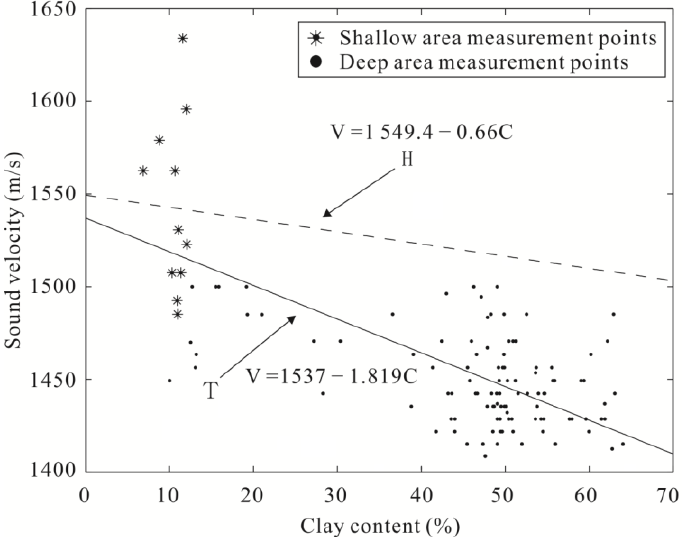
Figure 7. Clay content versus sound velocity.